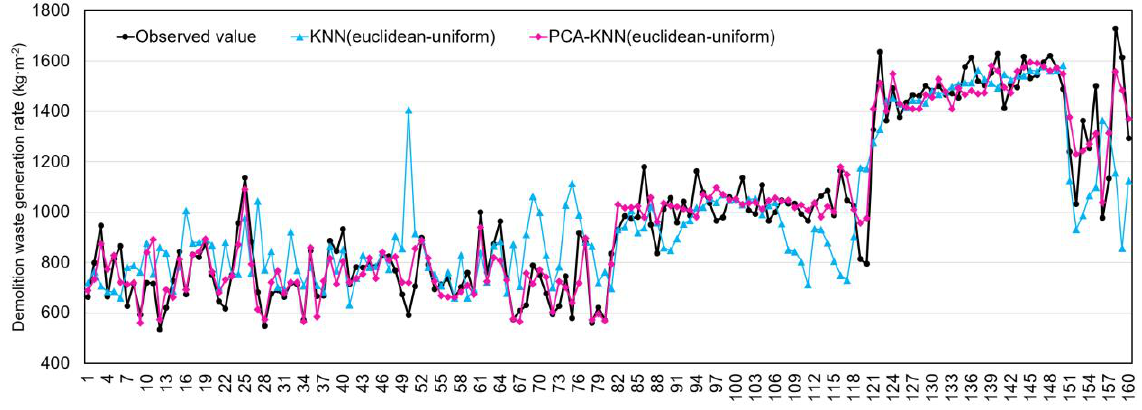
Figure 8. Comparison of prediction results by KNN (Euclidean uniform) and PCA − KNN (Euclidean uniform).